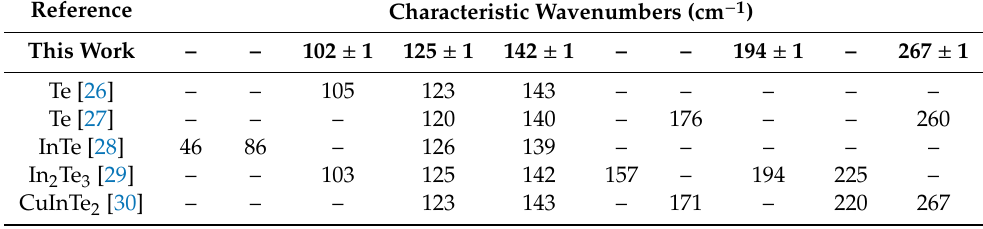
Figure 2. Raman spectra of Ta-doped InTe thin films S1–S4.